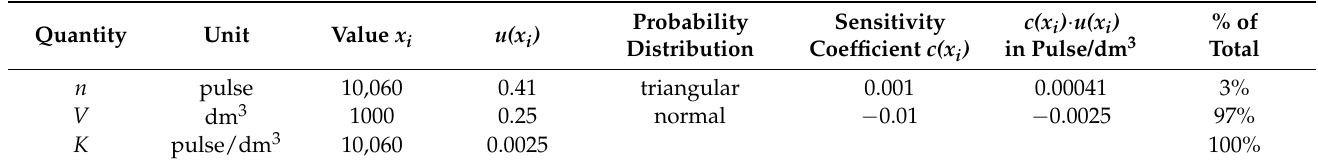
Table 2. Uncertainty budget for calibration using